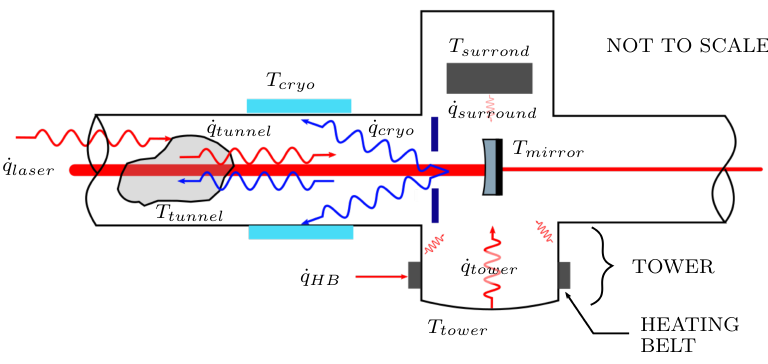
Figure 3. Identified radiative heat transfer sources relevant to the etalon control; also shown is the heat transfer due to the heating belt actuator, ˙ q HB . Red arrows indicate heat transfer into the mirror, blue indicate heat transfer